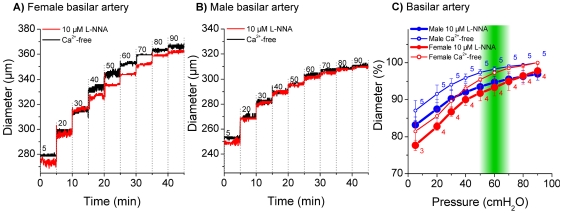
Pressure dependent diameter of female and male basilar artery.Original traces of female (A) and male (B) basilar artery in 10 µM L-NNA and Ca2+-free solution. Diameter in % in 10 µM L-NNA and Ca2+-free solution (C), % values were normalized to maximal diameter measured in Ca2+-free at 90 cmH2O. 100% = 329.2 µm±17.5 in Ca2+-free at 90 cmH2O in female animals and 313.8 µm±7.7 in Ca2+-free at 90 cmH2O in male animals.